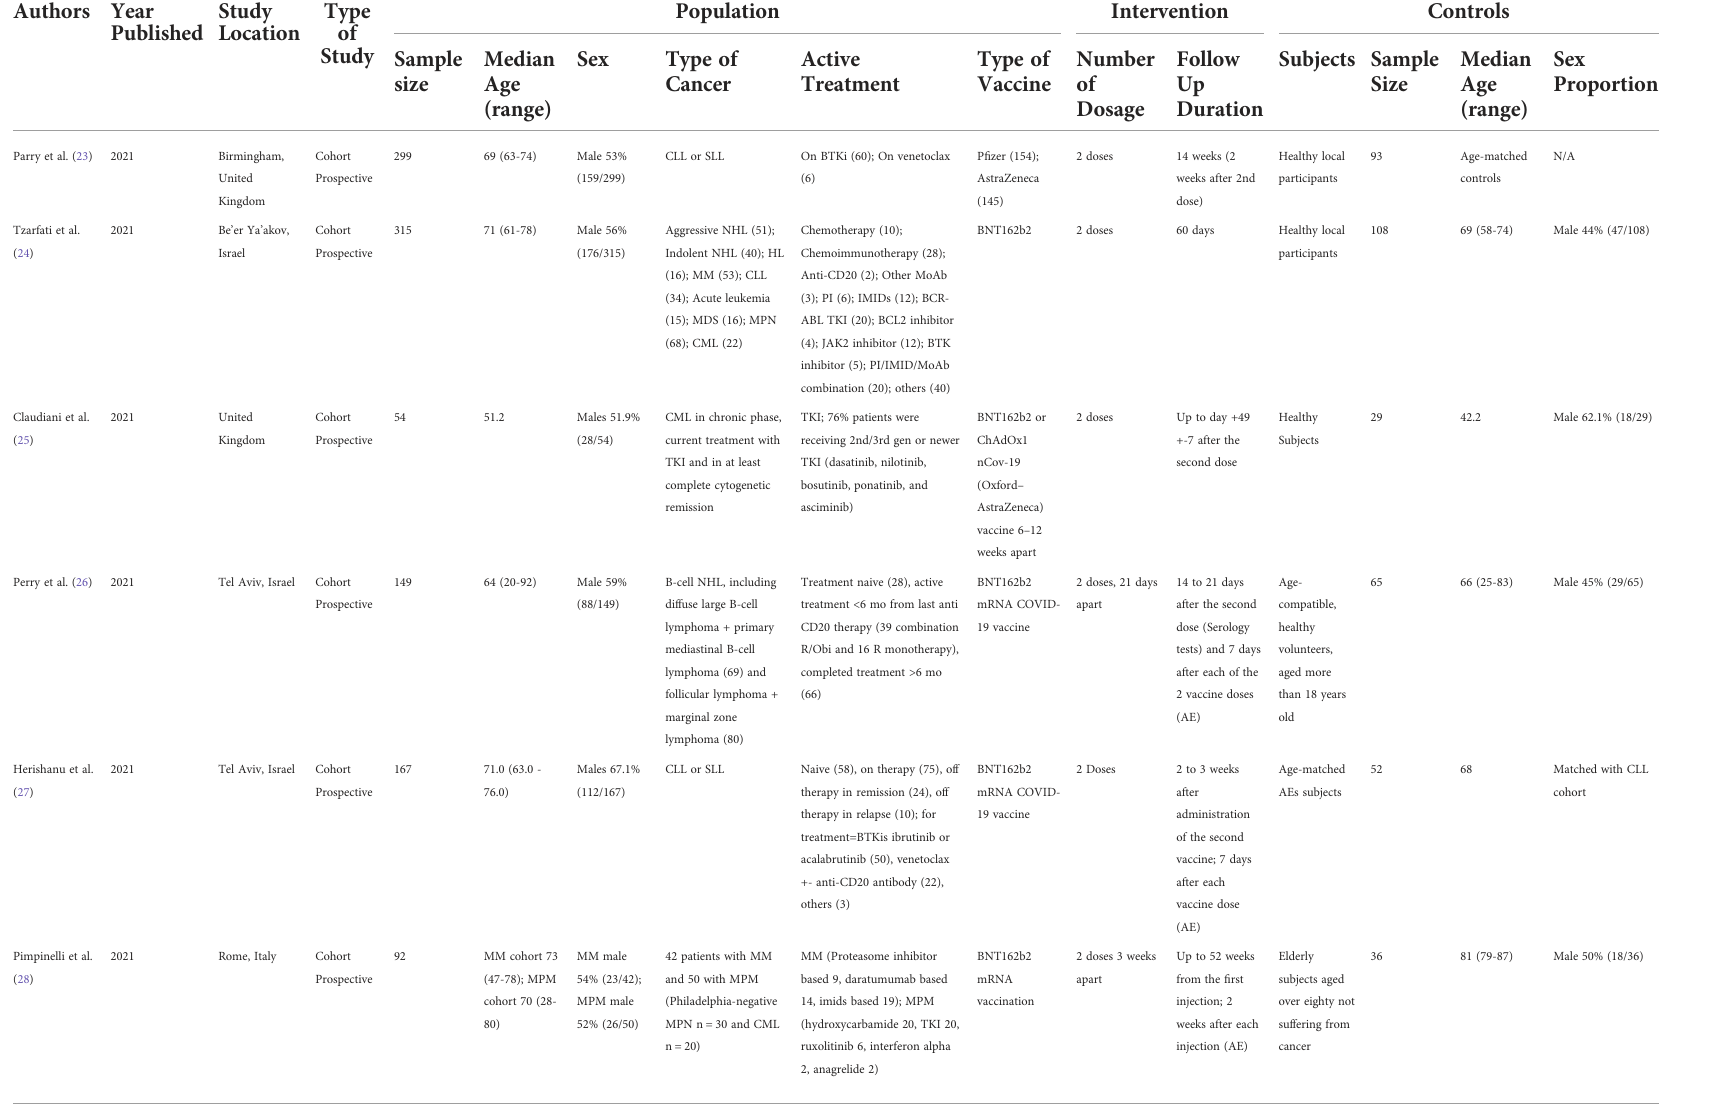
TABLE 2 Population characteristics of the included